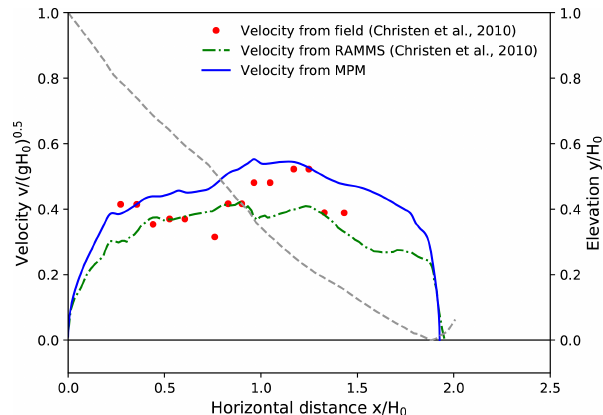
Figure 15. Front velocity distribution along the flow path for Case V: Vallée de la Sion (VdlS), 31 January 2003 (Sion, Switzer- land). Drop height H 0 =